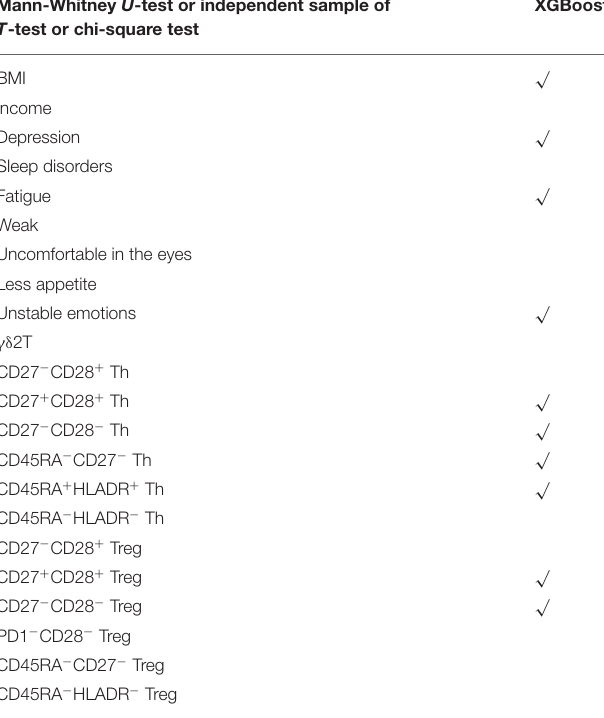
TABLE 6 | The selection of important